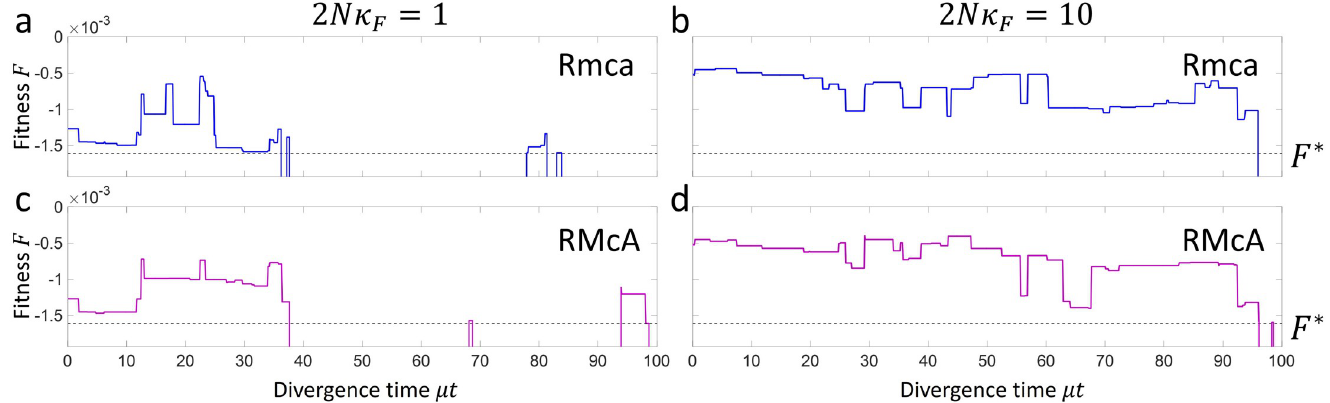
Fig 3. Plot of the times series of two hybrids Rmca (a & b) and Rmca (c & d) at population scaled fitness contributions of 2 N κ F = 1 (a & c) and 2 N κ F = 10 (b & d). Times when the fitness of a hybrid drop below the critical value F � (dashed line) correspond to DMIs. https://doi.org/10.1371/journal.pcbi.1007177.g003 PLOS Computational Biology | https://doi.org/10.1371/journal.pcbi.1007177 July 23,